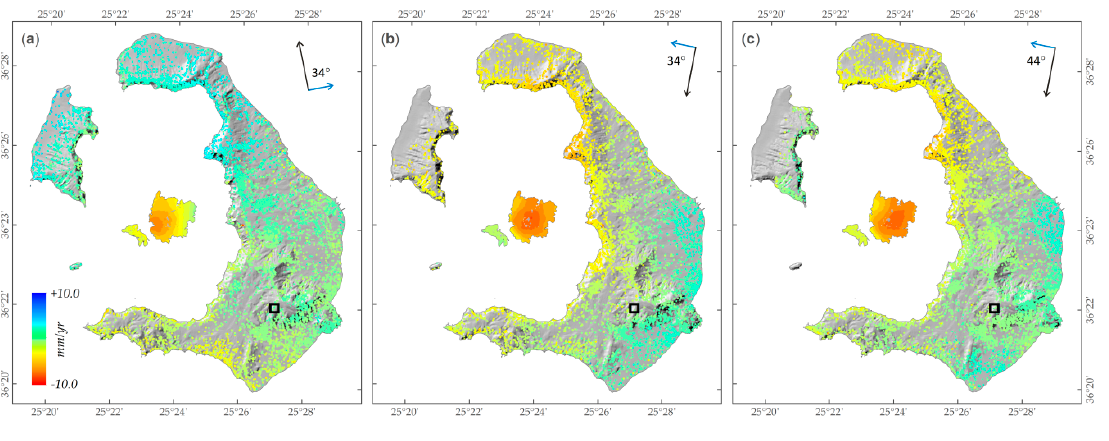
Figure 3. Sentinel-1 MT-InSAR LOS displacement rates of Santorini volcano for the period 2014–17 ( a ) Ascending orbit 029; ( b ) Descending orbit 109; ( c ) Descending orbit 036. Displacement rates are given relative to the reference point, marked by a rectangle. The line-of-sight and azimuth directions of the satellite are displayed by blue and black arrows, respectively. LOS velocity is negative away from the satellite. Values in degrees correspond to the incidence angles.